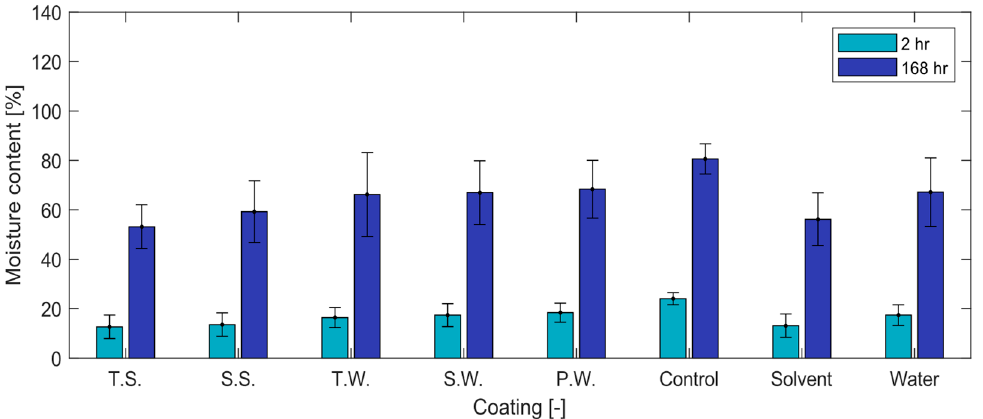
Figure 16. Moisture content changes in coated and uncoated wood samples after 2 and 168 h (7 days) Figure 16. Average moisture content changes in coated and uncoated wood samples after 2 and of water immersion. 168 h (7 days) of water immersion. The control represents the uncoated samples, and Solvent and Water denote the total average moisture content for the grouped solvent and water-based coatings,